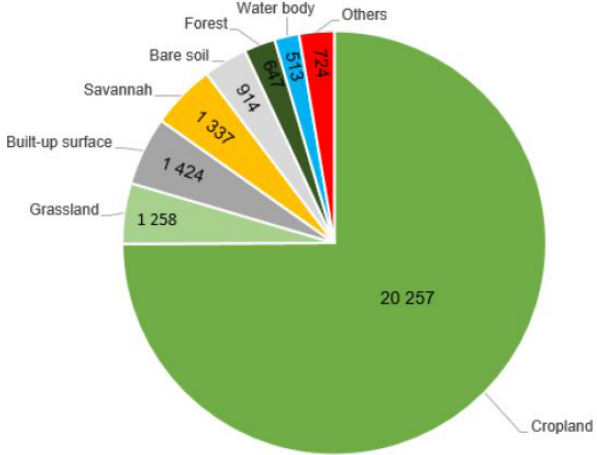
Figure 4. Distribution of the main land cover types (in number of